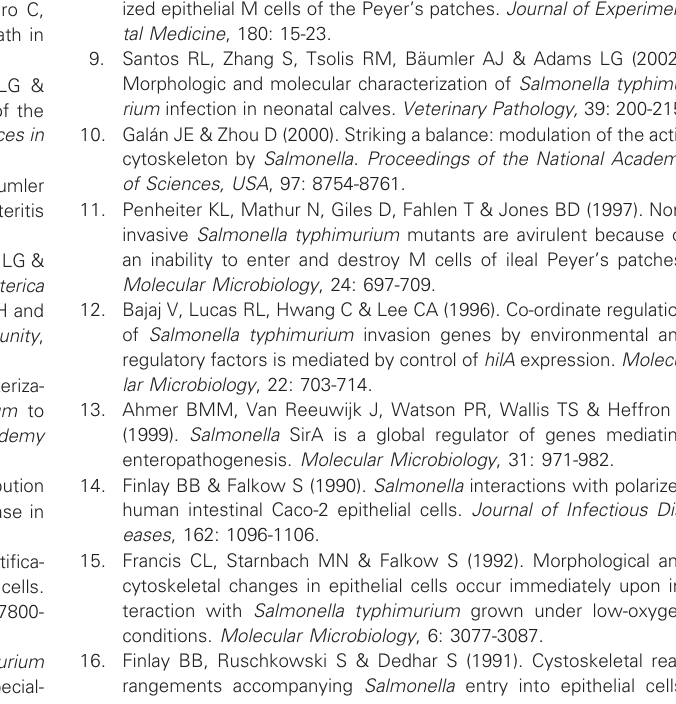
nd = not determined, CFU = colony-forming